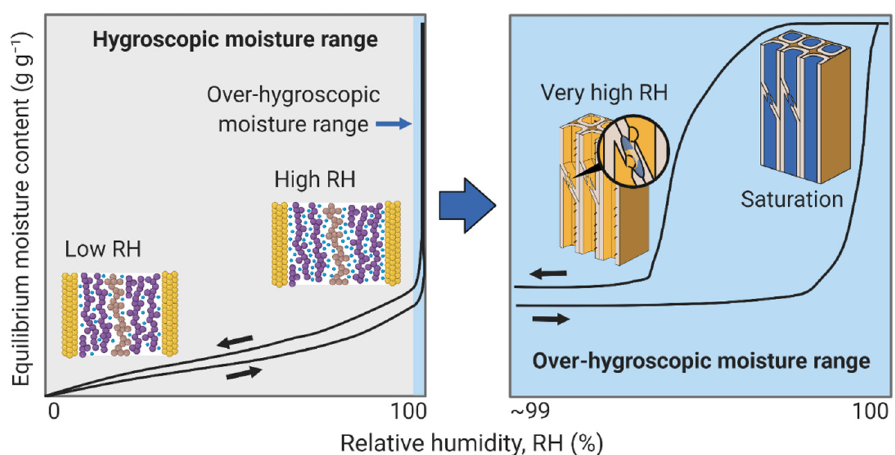
Figure 2. Schematic illustration of sorption isotherms in the hygroscopic and over-hygroscopic moisture ranges. Both absorption (right-pointing arrows) and desorption (left-pointing arrows) isotherms are illustrated. The right diagram is a zoom of the over-hygroscopic moisture range. In the hygroscopic range, water is predominantly found within the cell walls interacting with the wood polymers. In the over-hygroscopic range, the dominating sorption mechanism is capillary condensation in the macro-void structure.